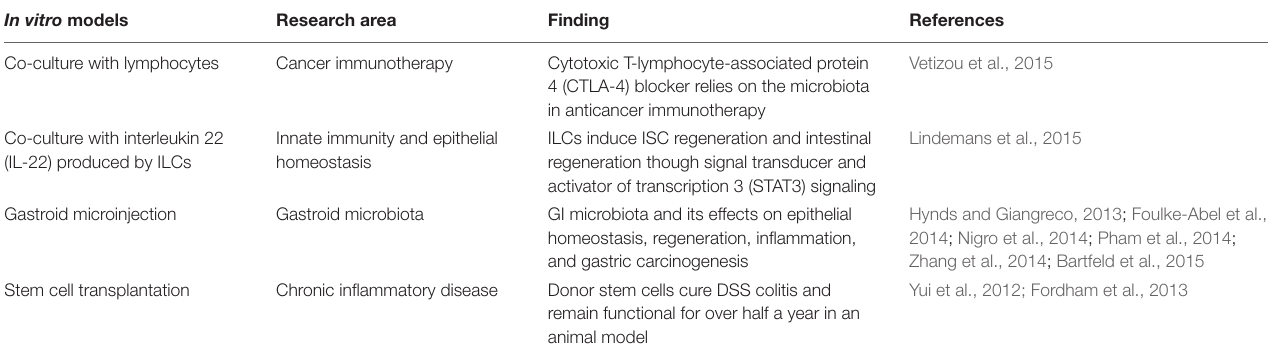
TABLE 1 | Optimization of organoids for immunological research. In vitro